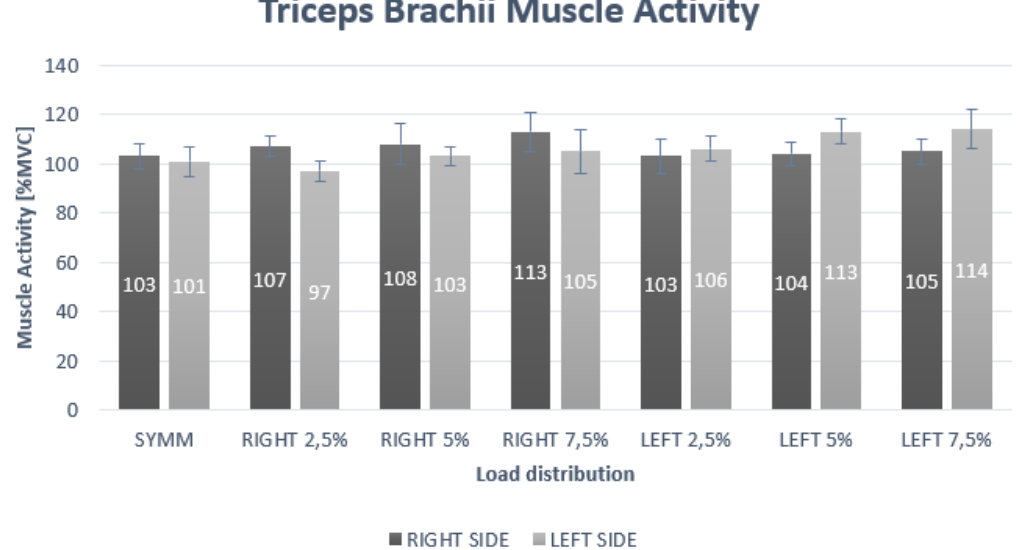
ff erent loading